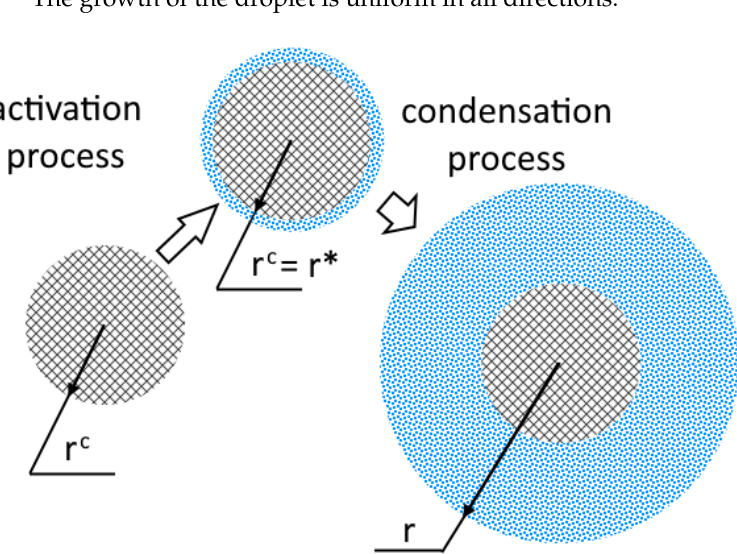
Figure 1. Schematic representation of the heterogeneous condensation process, inspired by [26]. Furthermore, we assume that the activation of particles occurs only for particles of which the radius is greater than the critical radius of the nucleus r ∗ (Figure 2) and that the rest of the particles do not participate in the process. Figure 2 shows the particle size distribution function g ( r ) . The arrow indicates the direction of propagation of the boundary of the activated particle with increasing supersaturation.